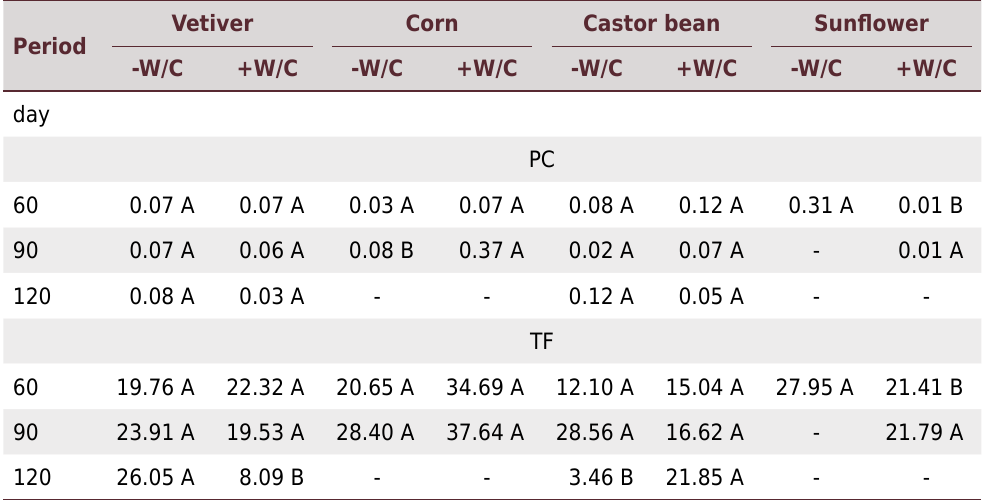
Table 3. Phytoextraction coefficient (PC) and translocation factor (TF) for vetiver, corn, castor bean, and sunflower species obtained in different evaluation periods, without (-W/C) and with (+W/C) correction of soil pH (mean of four